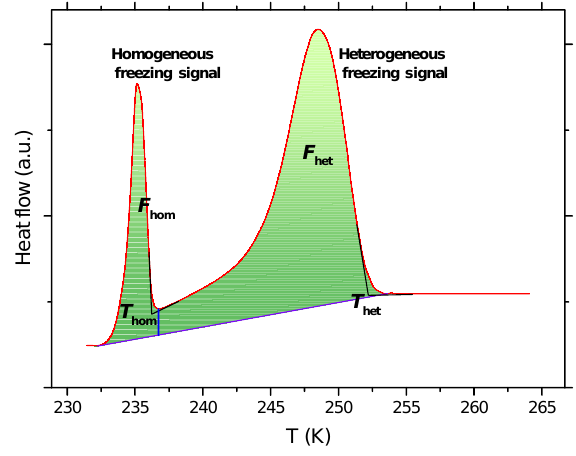
Figure 1. A typical DSC thermogram, showing freezing onset tem- peratures T het and T hom and the asymptotes used for their construc- tion (black lines), as well as frozen fractions F het and F hom (shaded areas), which are normalized F het + F hom = 1. The area under each peak corresponds to the volume of water that froze homogeneously or heterogeneously. The straight violet line connects the heteroge- neous freezing signal onset with the end of the homogeneous freez- ing signal and is taken as the base line for evaluating the total frozen fraction. The vertical blue line marks the minimum intensity be- tween the homogeneous and heterogeneous freezing peak and is taken as the separator between the areas under the heterogeneous and homogeneous freezing peaks. Note that frozen fractions are de- termined in the time domain (heat flow as a function of time) and not in the temperature domain shown here for